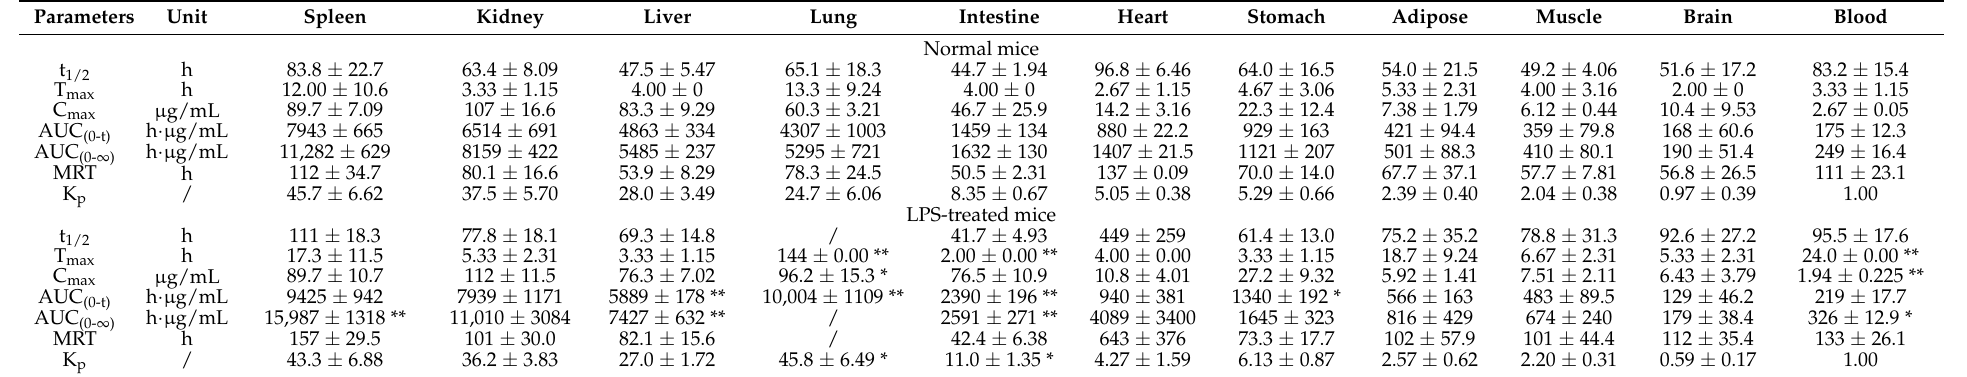
Table 2. Pharmacokinetic parameters of TET in major tissues and blood after a single i.t. administration in normal and LPS-treated mice ( n = 3, Mean ±